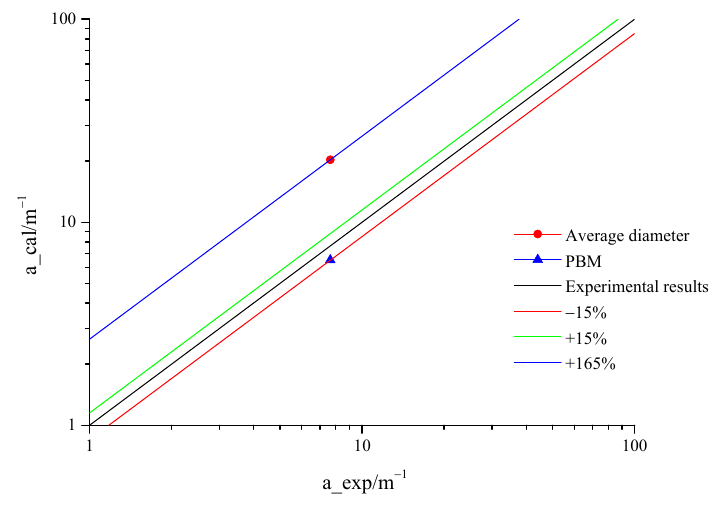
Figure 14. Comparison of interfacial area.